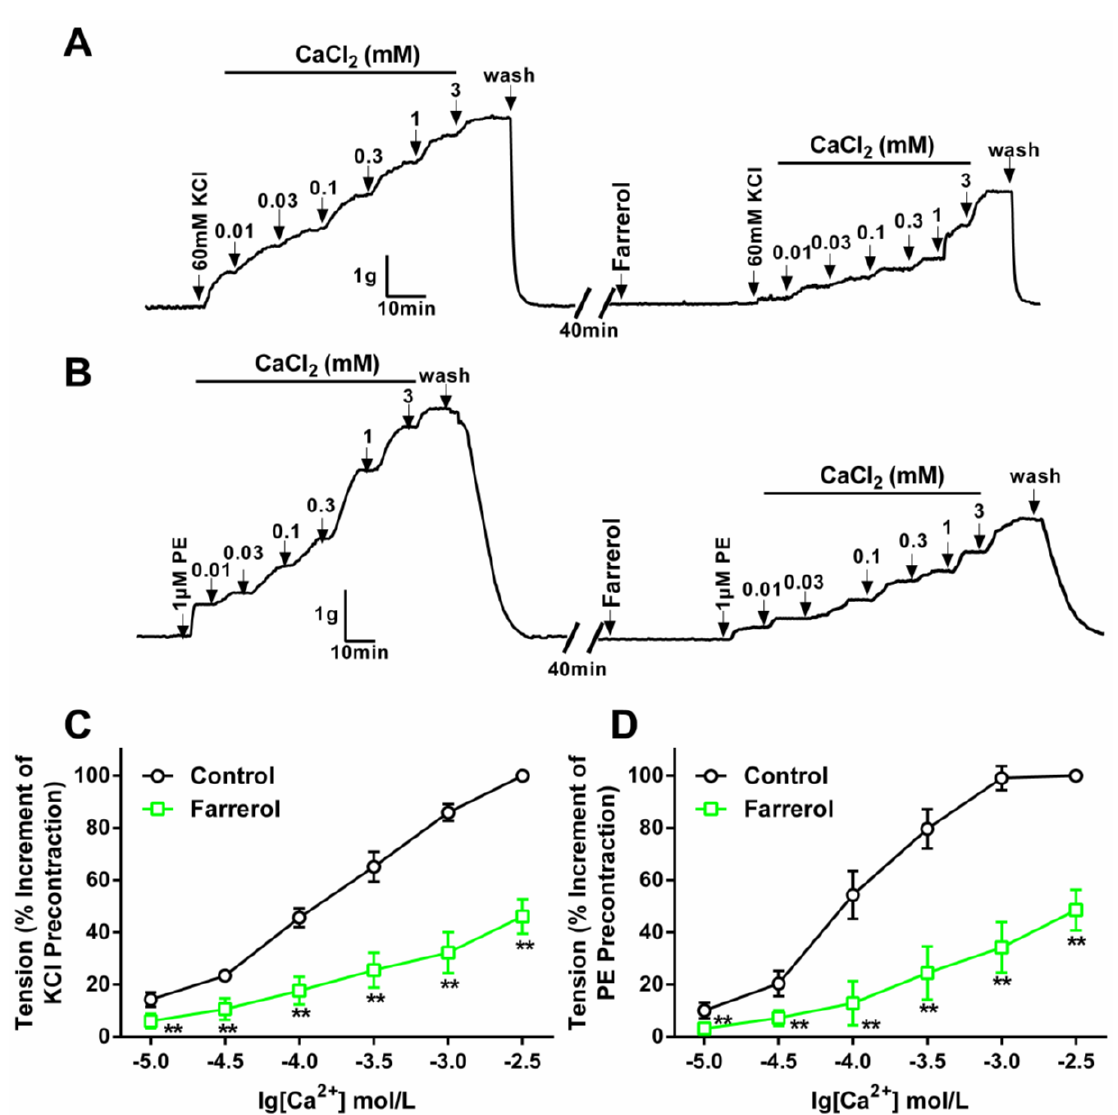
Figure 3. Effect of farrerol on extracellular Ca 2+ -induced contractions on rat ndothelium-denuded aortic rings. ( A , B ) Original tension tracings of the effects of giving prior farrerol or not on KCl- ( A ) or PE-induced ( B ) contractions. Drug addition is indicated by the vertical arrows. Contractions were presented as gram (g); and ( C , D ) The maximal contraction induced by CaCl was taken as 100%. Results are expressed as means ± 2